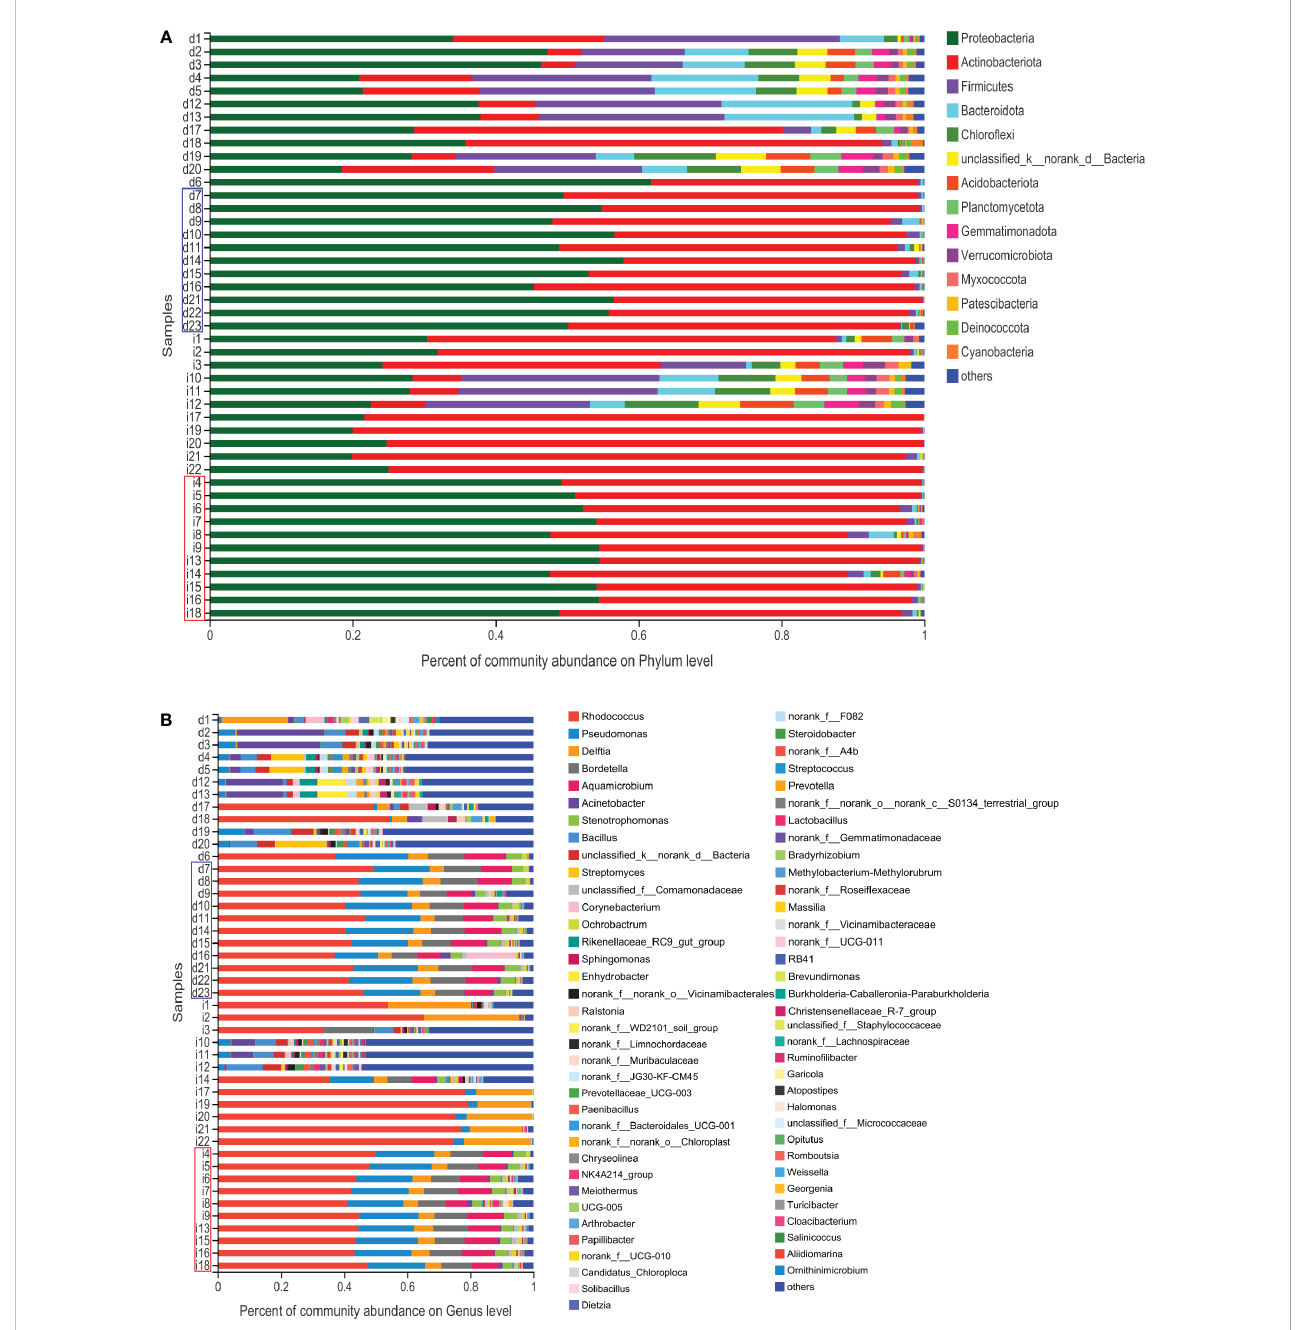
FIGURE 4 Histogram of the microbial community. The abundance of the community in each sample in the two groups. (A) At the phylum level. (B) At the genus level. The DM (red) and IM samples (blue) indicate similar abundances of microbial